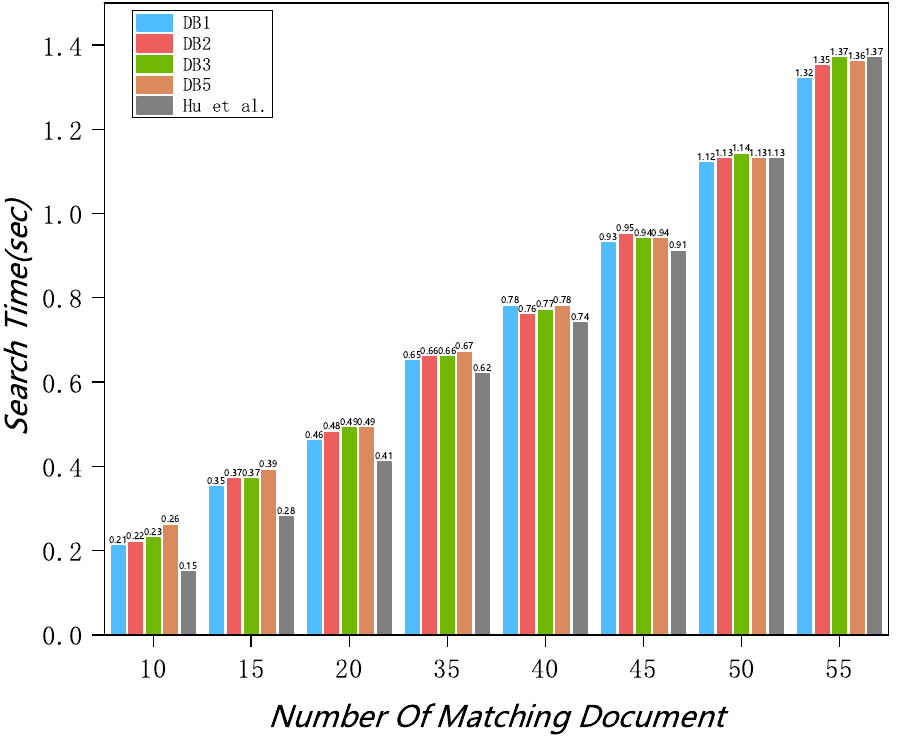
Figure 7. Comparision of search